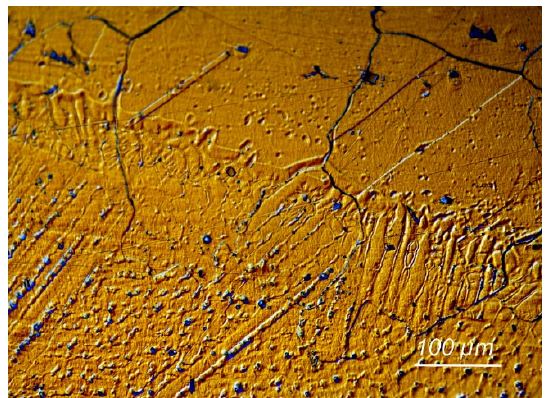
Figure 10. Micrograph showing interface between weld–fusion line and Incoloy 800HT nickel alloy (Nomarski contrast). Metals 2020 , 10 , 559